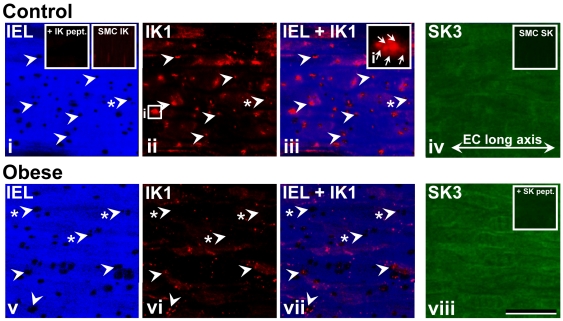
SK3 and IK1 distribution.Confocal immunohistochemisty demonstrates SK3 (SKCa) and IK1 (IKCa) distribution in arteries from control(i–iv) and obese (v–viii) rat (NB. same vessel region shown in i–iii and v–vii, respectively). Autofluorescence demonstrates internal elastic lamina (IEL) morphology and associated holes (i–iii, and v–vii, examples arrowed) as potential myoendothelial gap junction/microdomain sites. IKCa labeling shows intense punctate localization at discrete points in the endothelium of arteries from control and obese rats (i–iii and v–vii, respectively), which correlates to IEL hole sites (examples with arrows; see Table S1) to a greater extent in obese (v–vii) compared to control (i–iii; examples of IEL holes without IKCa localization arrowed, asterisk; see Table S1). Aggregates of IKCa densites of >1 plaque occur in control and obese arteries (example, boxed region in ii shown in iii, inset). Reconstructed confocal series of the full endothelial depth show diffuse SKCa labeling across the cell surface and cytoplasm of control (iv) and obese (viii) rat arteries, and lack of localization to IEL hole sites. IKCa and SKCa were absent in smooth muscle (i, right inset; iv, inset). Controls, as peptide block (i, left inset and viii, inset, respectively) and incubation in secondary antibody alone (data not shown) show absence of labeling. In all panels, longitudinal vessel axis runs left to right (example, iv). Bar, 20 µm; inset box width, 5 µm.